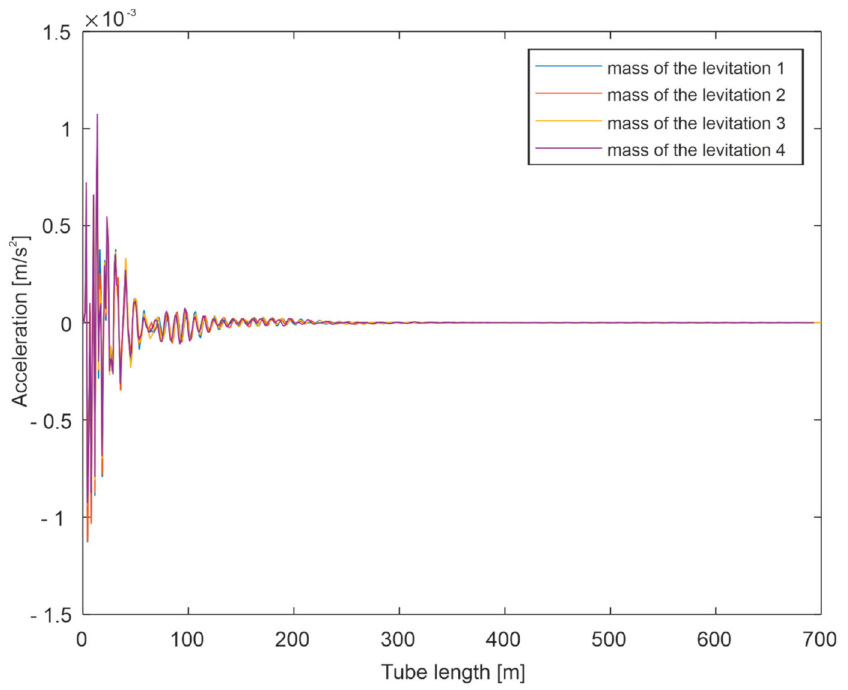
Figure 22. Acceleration on the levitation system in the direction z for 1000 km / h.